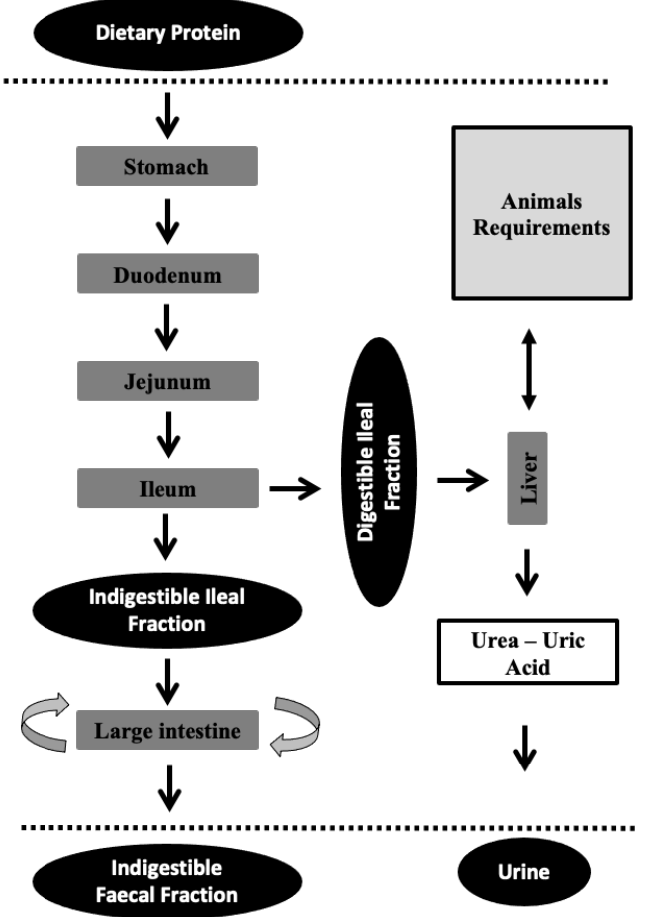
Figure 1. The protein partitioning and utilization in monogastric animals. The dotted lines symbolize the interior of the animal. The different arrows in the large intestine refer to the conversion of some amino acids into others produced by the microbiota.